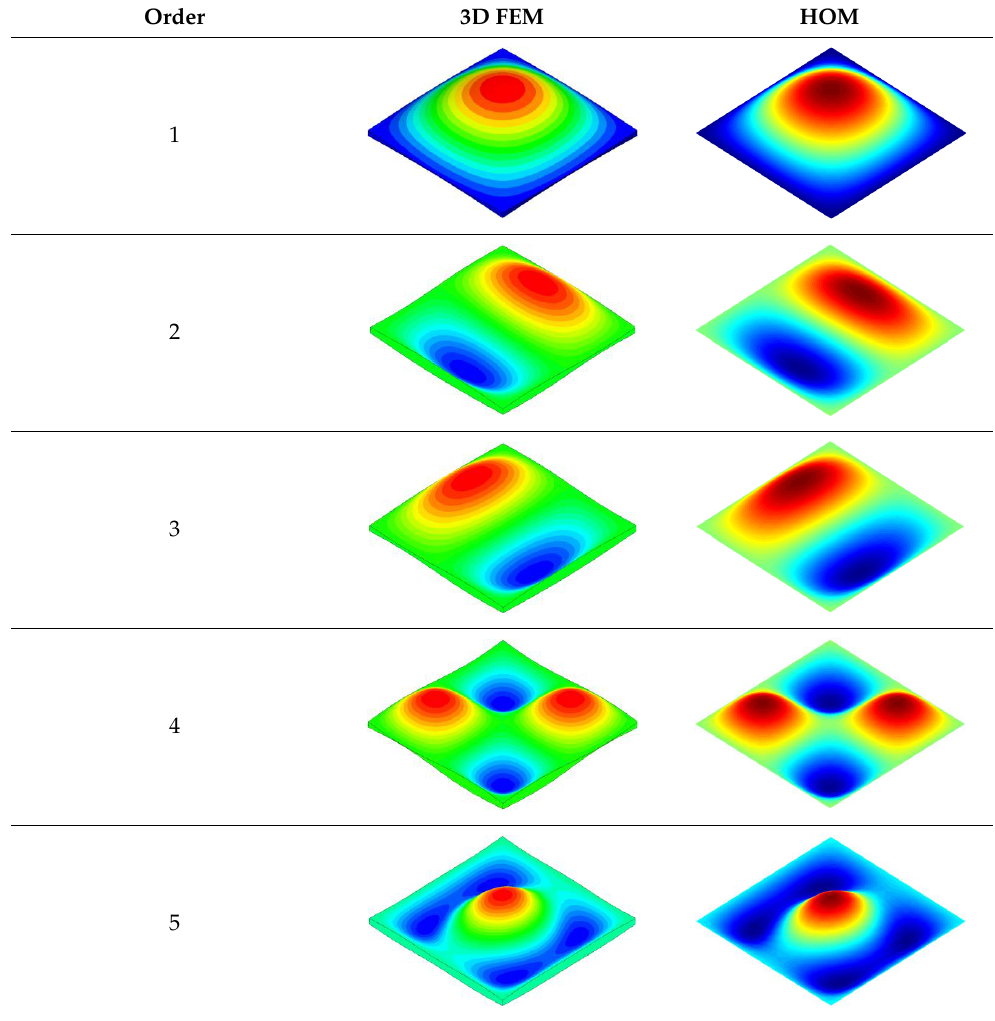
Table 4. First five order mode shapes of the SSSS four-layer periodic plate. Order